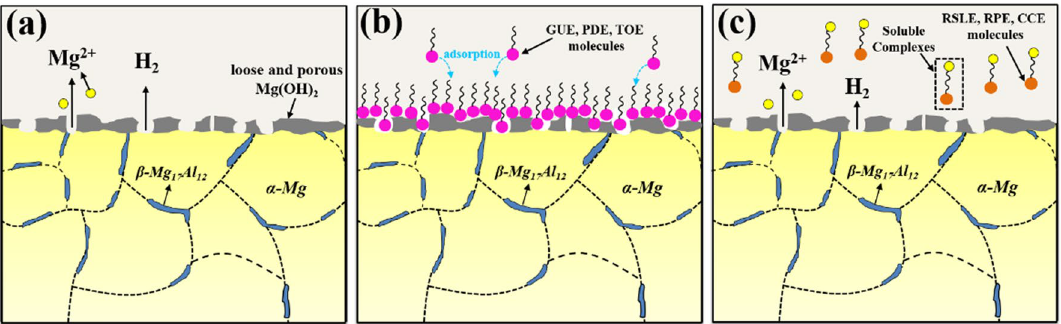
Figure 11. Schematic diagrams of corrosion mechanisms of AZ91 alloy in 3.5 wt% NaCl solution without and with TCM extracts. ( a ) Blank solution; ( b ) with addition of GUE, PDE or TOE; ( c ) with addition of RSLE, RPE or